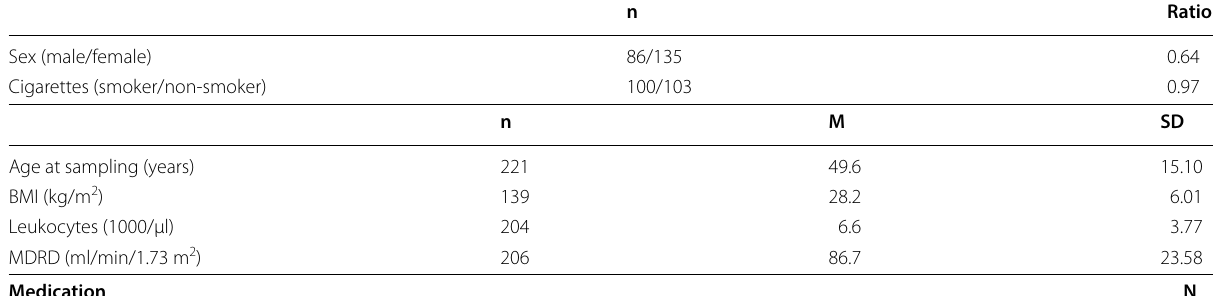
Table 1 Sample characteristics and demographic data of bipolar patients